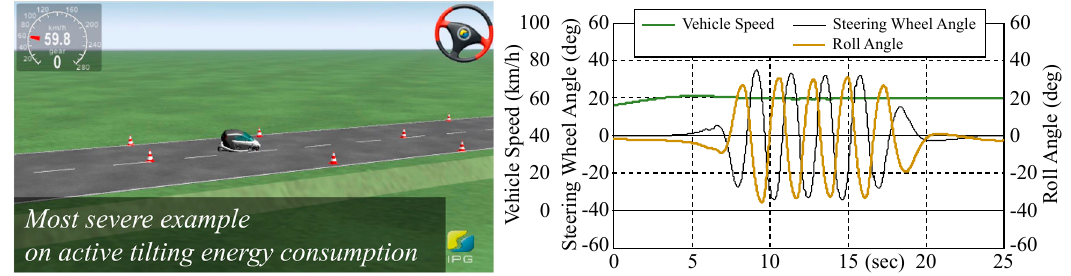
Figure 32. Driving on slalom course.